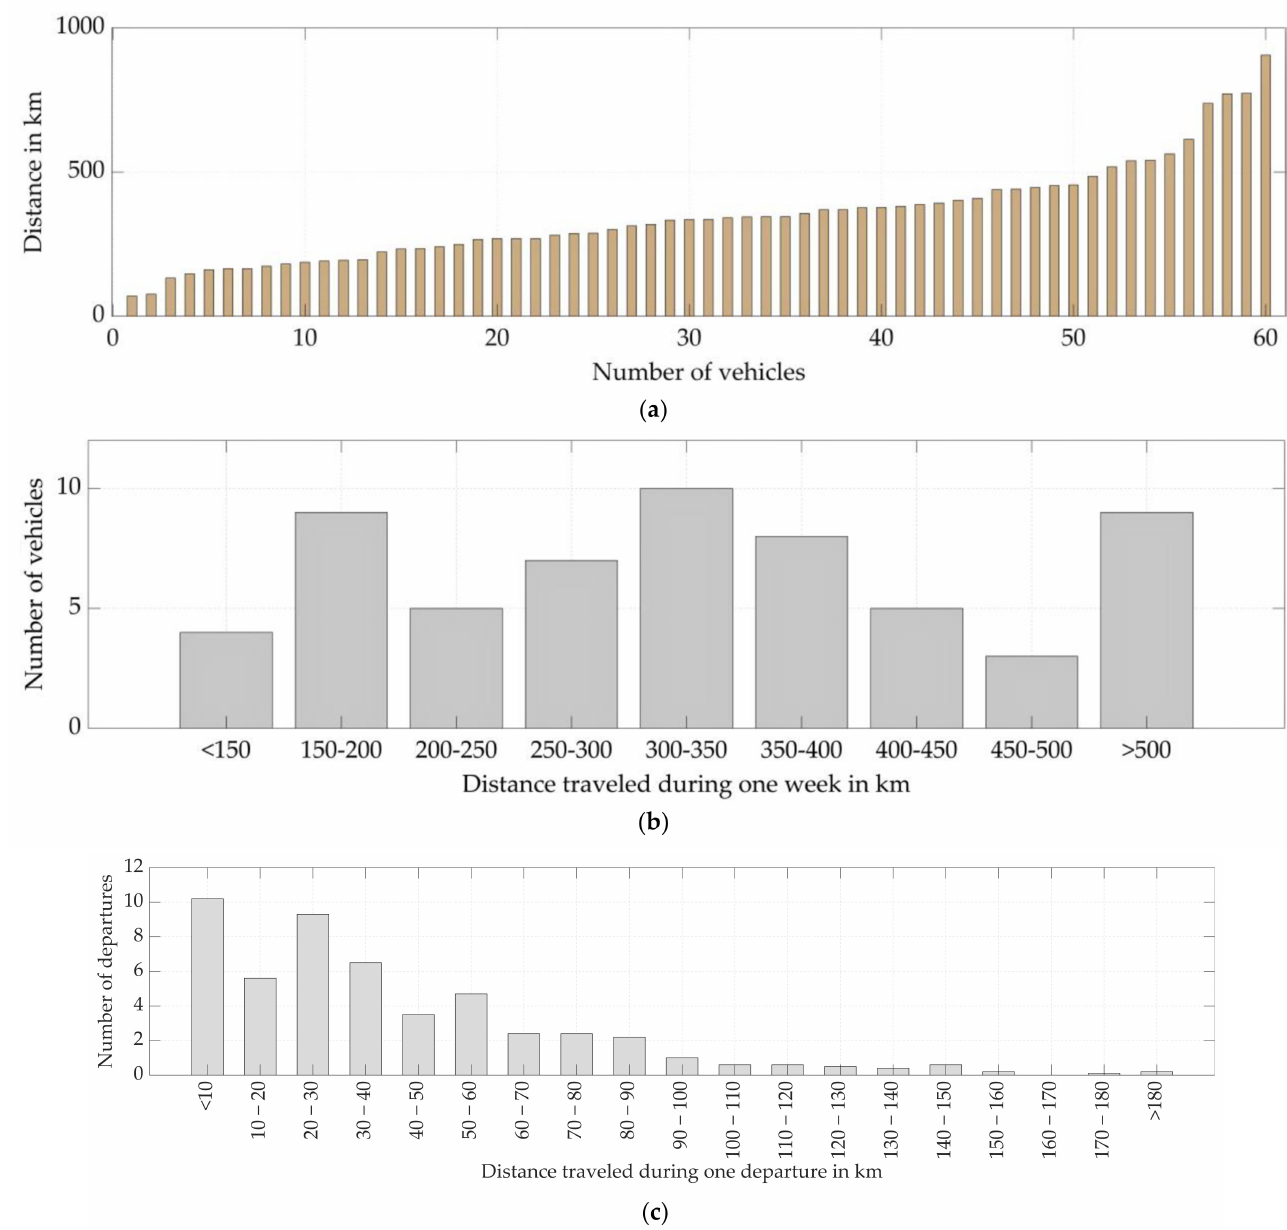
Figure 8. Diagrams representing the road most frequently driven by the vehicles that have been analyzed; ( a ) the entire distance traveled by each vehicle during the one week; ( b ) the distance most frequently driven by the selected fleet for the entire week; ( c ) the distance most frequently driven by the selected fleet during single